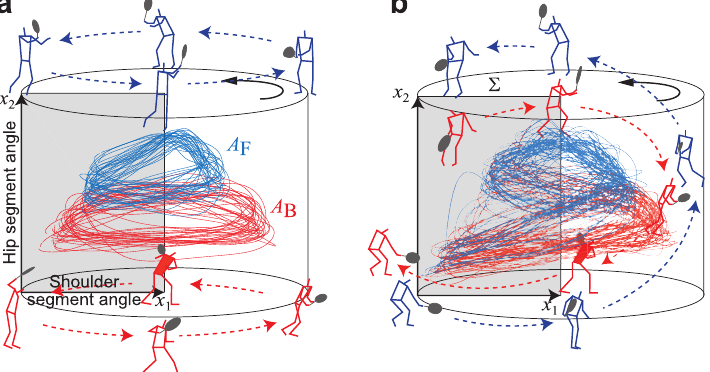
Figure 7. Trajectories in three-dimensional cylindrical phase space. ( a ) Periodic input condition, ( b ) switching input condition. The stick pictures show forehand and backhand striking movements at each point in the time series. Modified with permission from [40], Hum. Mov. Sci.